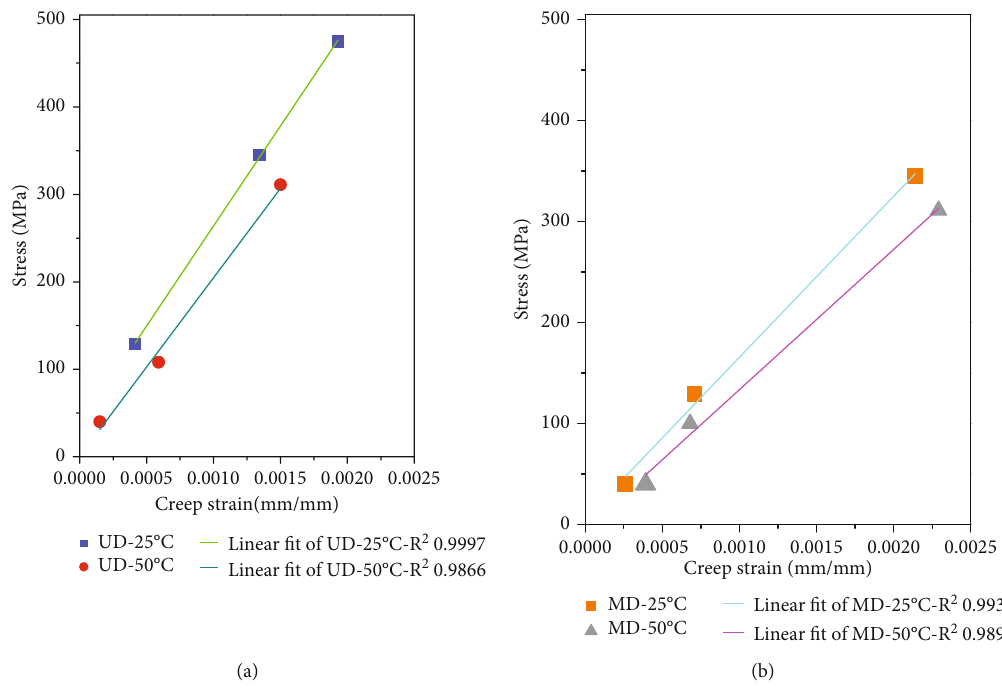
Figure 2: Isochronous curves at 25 ° C and 50 ° C for (a) the UD and (b) the MD